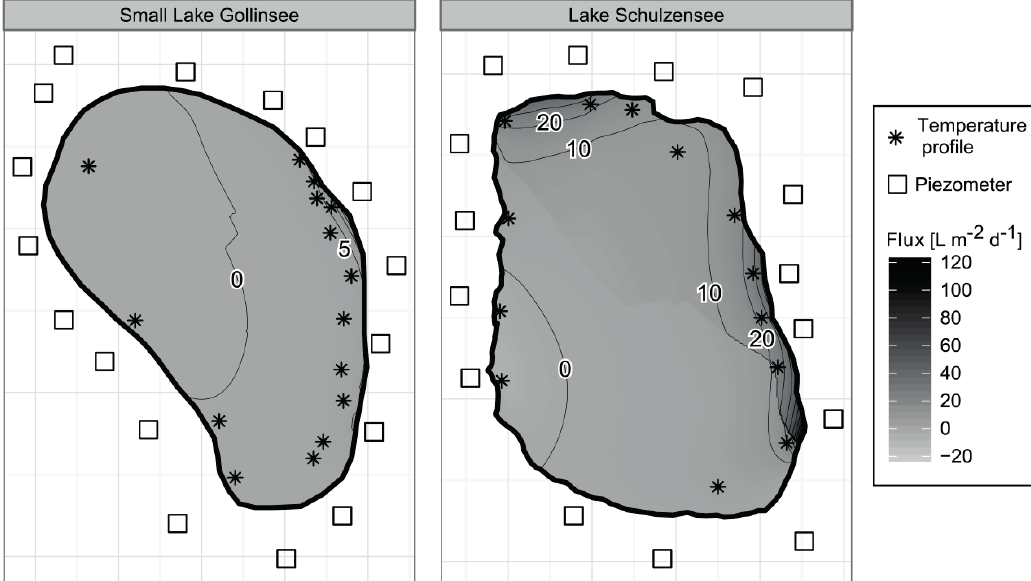
Fig. 2 Fluxes calculated using mean VHGs in the week of the temperature measurements. Contour lines indicate levels of fluxes. Squares and asterisks indicate locations of the piezometers and sediment temperature profiles